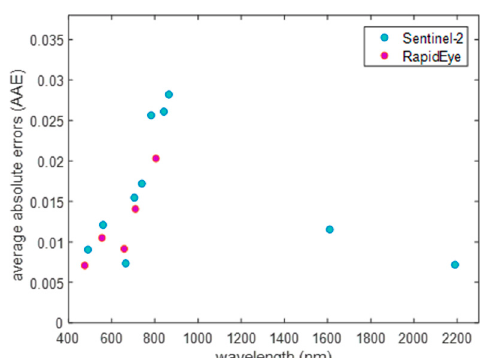
Figure 6. The average absolute errors (AAEs) calculated between RapidEye and Sentinel-2 measured reflectance and their corresponding best-fit reflectance from LUTs. The AAE has been calculated from RapidEye (n = 30) and Sentinel-2 (n = 20) reflectance and their corresponding best fit reflectance from the LUTs, respectively. The AAE units are reflectance.